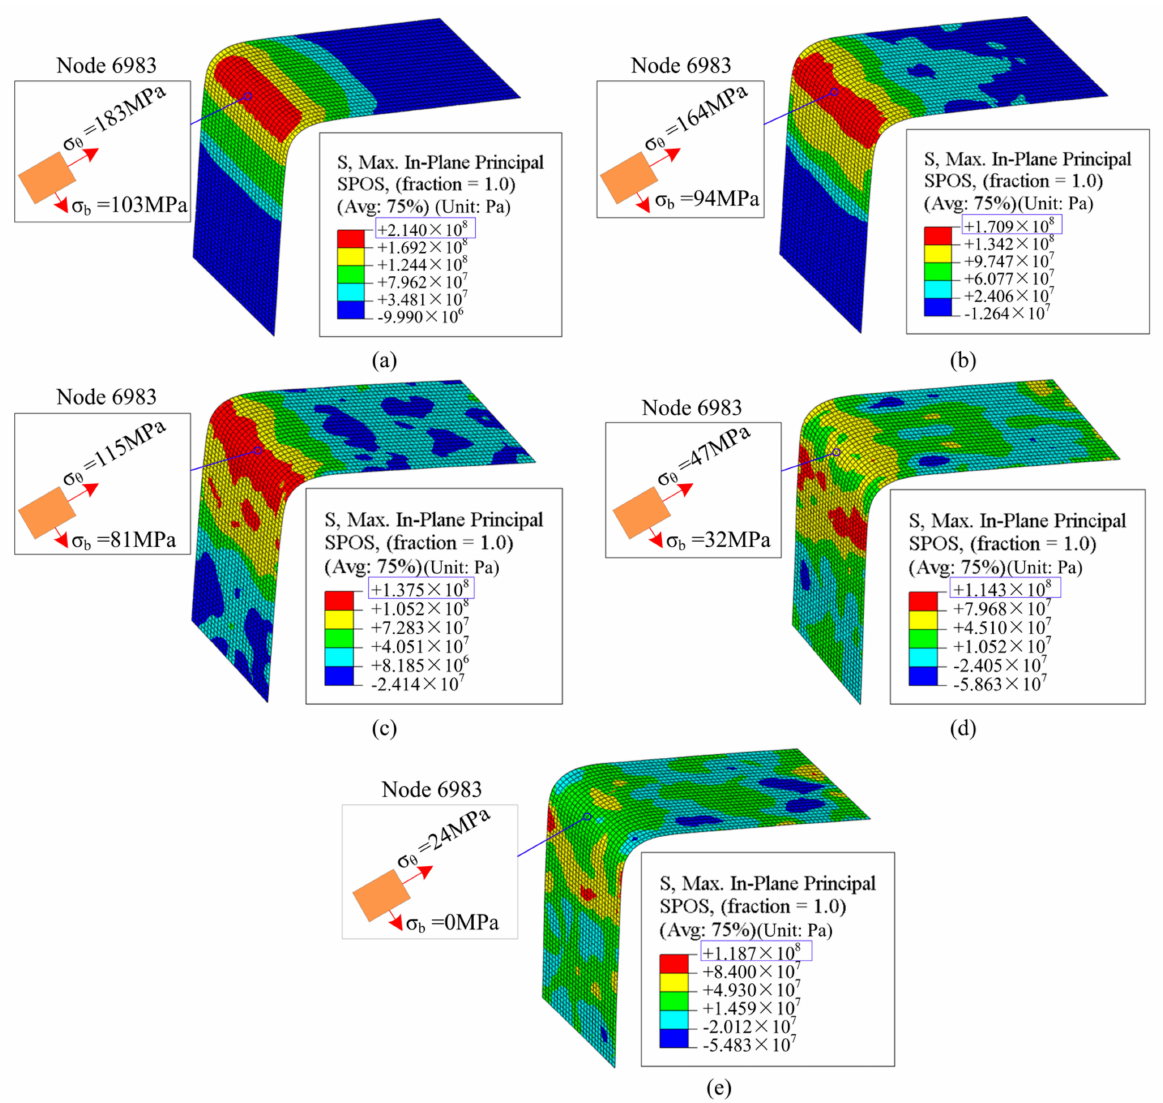
Figure 15. Stress distribution on the external surface under ( a ) quasi-static stamping or a discharge voltage of ( b ) 5 kV, ( c ) 6 kV, ( d ) 7 KV, and ( e ) 7.5 kV. The distribution of tangential stress on the inner layer of sheet metal at di ff erent discharge voltages is shown in Figure 16. Larger discharge voltages result in a more uneven distribution of tangential compressive stress in the inner layer, whereas the maximum tangential compressive stress is smaller and occurs at the straight-edge area of the metal